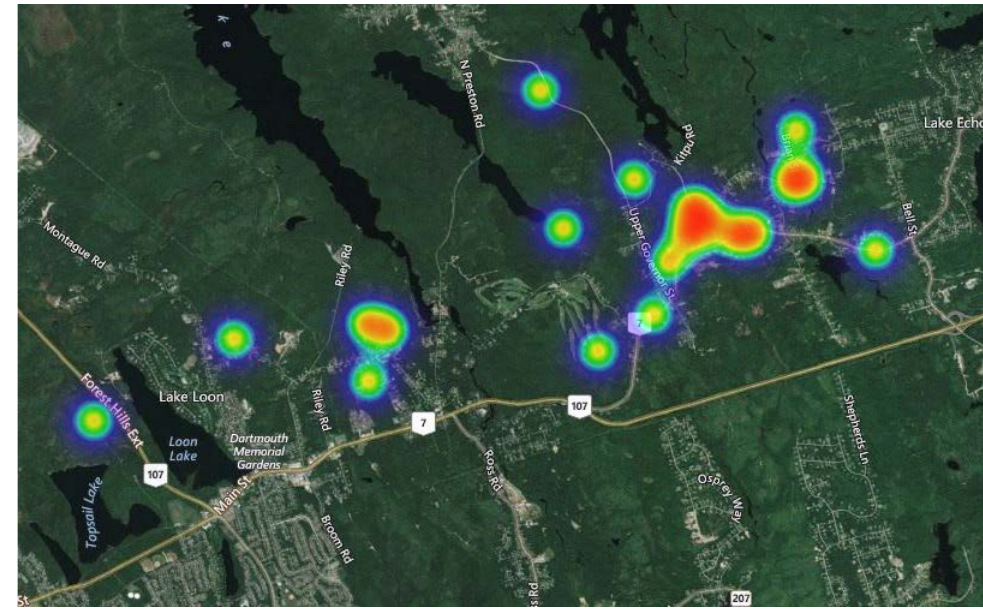
Figure 6. Greenspace interaction results.